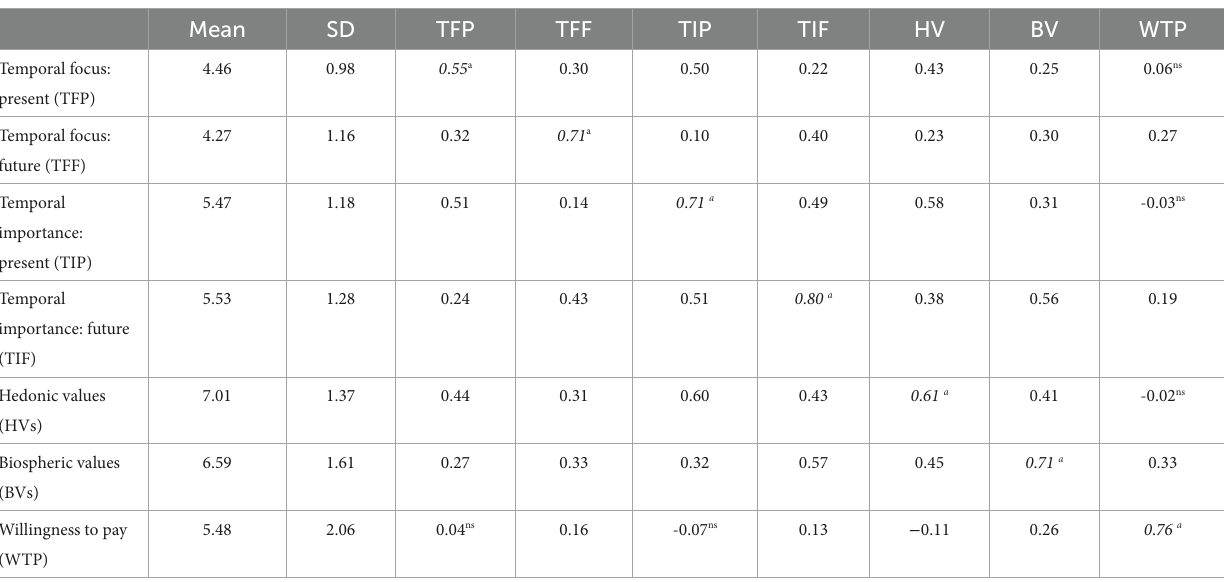
TABLE 2 Means, standardized deviations, and